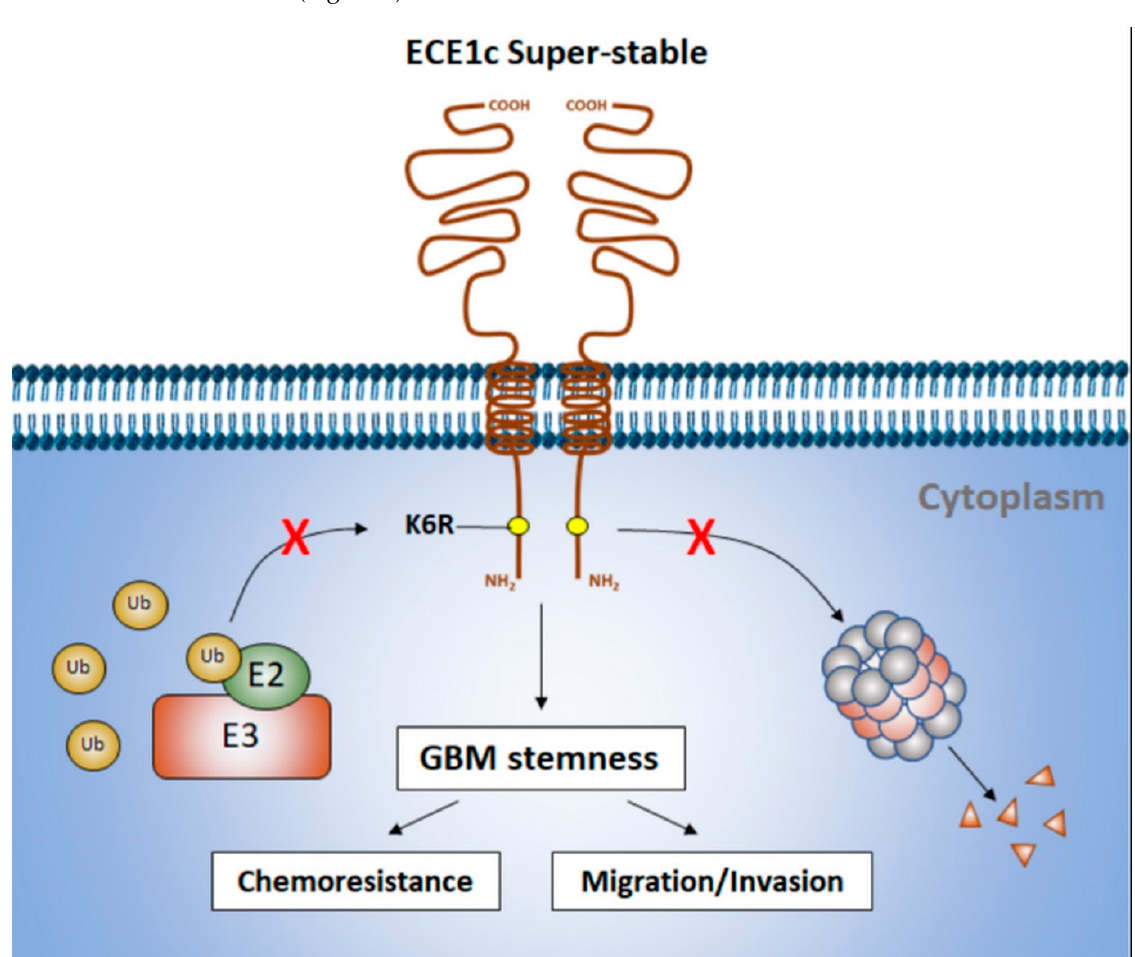
Figure 9. Proposed model. Lysine 6 (K6) is a plausible target for ubiquitination. Therefore, K6R mutation promotes a more stable ECE1c, thereby enhancing stem-like traits such as chemoresistance and cell migration/invasion. The mechanism of ubiquitination and the proteins involved in this process remain unclear and are discussed in Section 4.